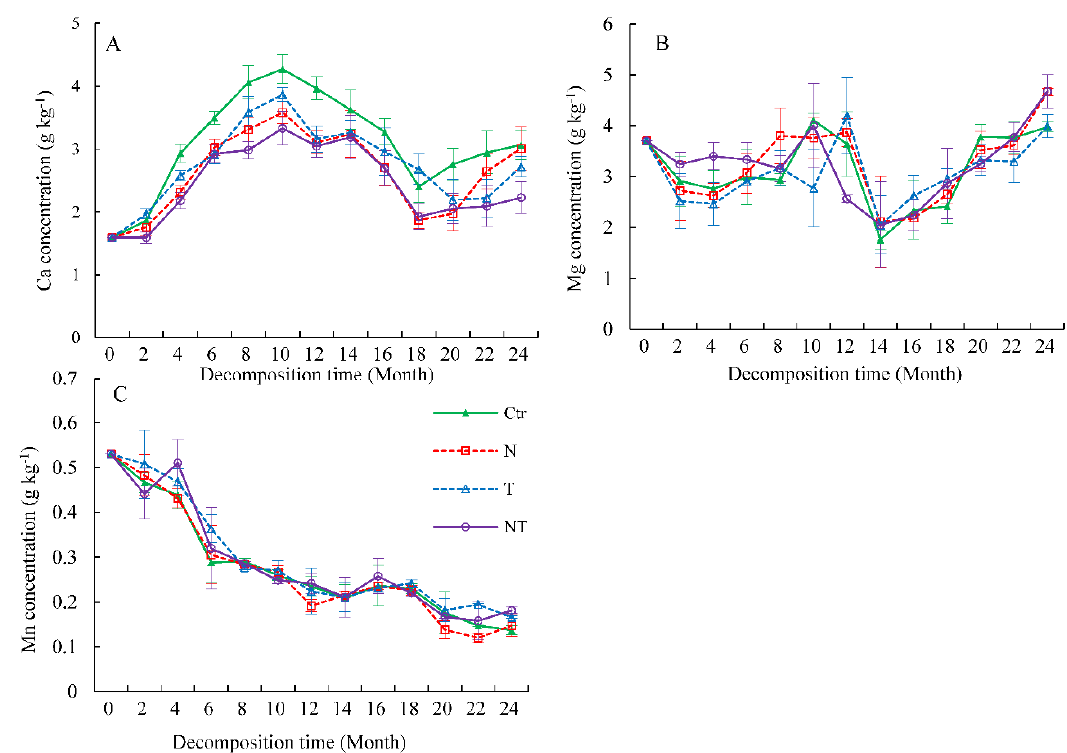
Figure 1. Changes in concentrations of Ca ( A ), Mg ( B ), and Mn ( C ) in leaf litter exposed in the field during the two-year experiment. Error bars represent standard deviations of the means ( n = 3). Ctr: without nitrogen deposition or throughfall reduction, N: nitrogen deposition (150 kg · N · ha − 1 · y − 1 ), T: throughfall reduction (10%), NT: nitrogen deposition (150 kg·N·ha − 1 ·y − 1 ) and throughfall reduction (10%). Table 1. F- and p- values of the linear mixed effect models on the effects of N deposition, throughfall reduction, sampling time and their interactions on the concentrations of Ca, Mg, and Mn during different decomposition stages. Significant effects are given in bold.